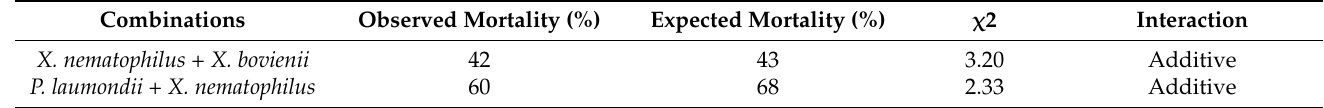
Figure 4. Cell-free supernatant 1:6.67 diluted against Philaenus spumarius nymphs. Cumulative larval mortality (three to five days) for the symbiont bacterial species Xenorhabdus bovienii , X. nematophilus X. kozodoii , Photorhabdus laumondii , and the combinations of X. nematophilus + X. bovienii and P. laumondii + X. nematophilus . No significant differences (n.s.) ( p < 0.05) for general linear model testing within pair-treatment comparisons of inoculation and no inoculation (control) of cell-free supernatants were found. Values are least-square means ± SE. Table 2. Interactions of the mixed cell-free supernatant applications Xenorhabdus bovienii + X. nematophilus and X. nematophilus + Photorhabdus laumondii . Expected mortality (ME) calculated as ME = MT1 + [MT2 x (1 − MT1)], where MT1 and MT2 are the observed mortality rates (%) recorded for single cell-free supernatant applications. Interactions were based on χ 2 ratio between expected and observed mortalities ( χ 2 = (MT1T2 − ME)2/ME, where MT1T2 is the observed mortality for each single